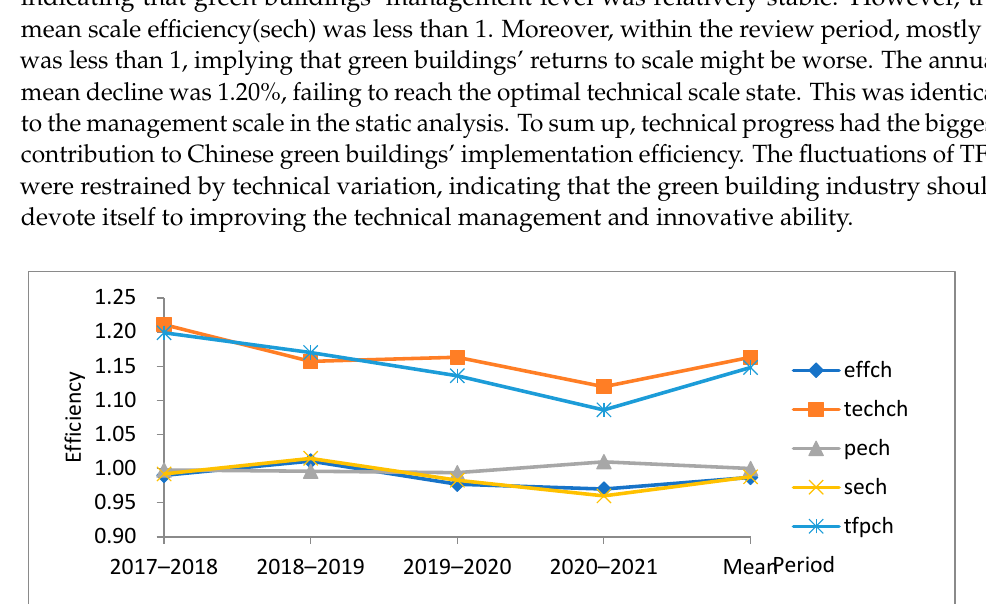
Table 8. Malmquist Index and its Decomposition of Chinese Green Buildings’ Implementation Ef- ficiency during 2017–2021.